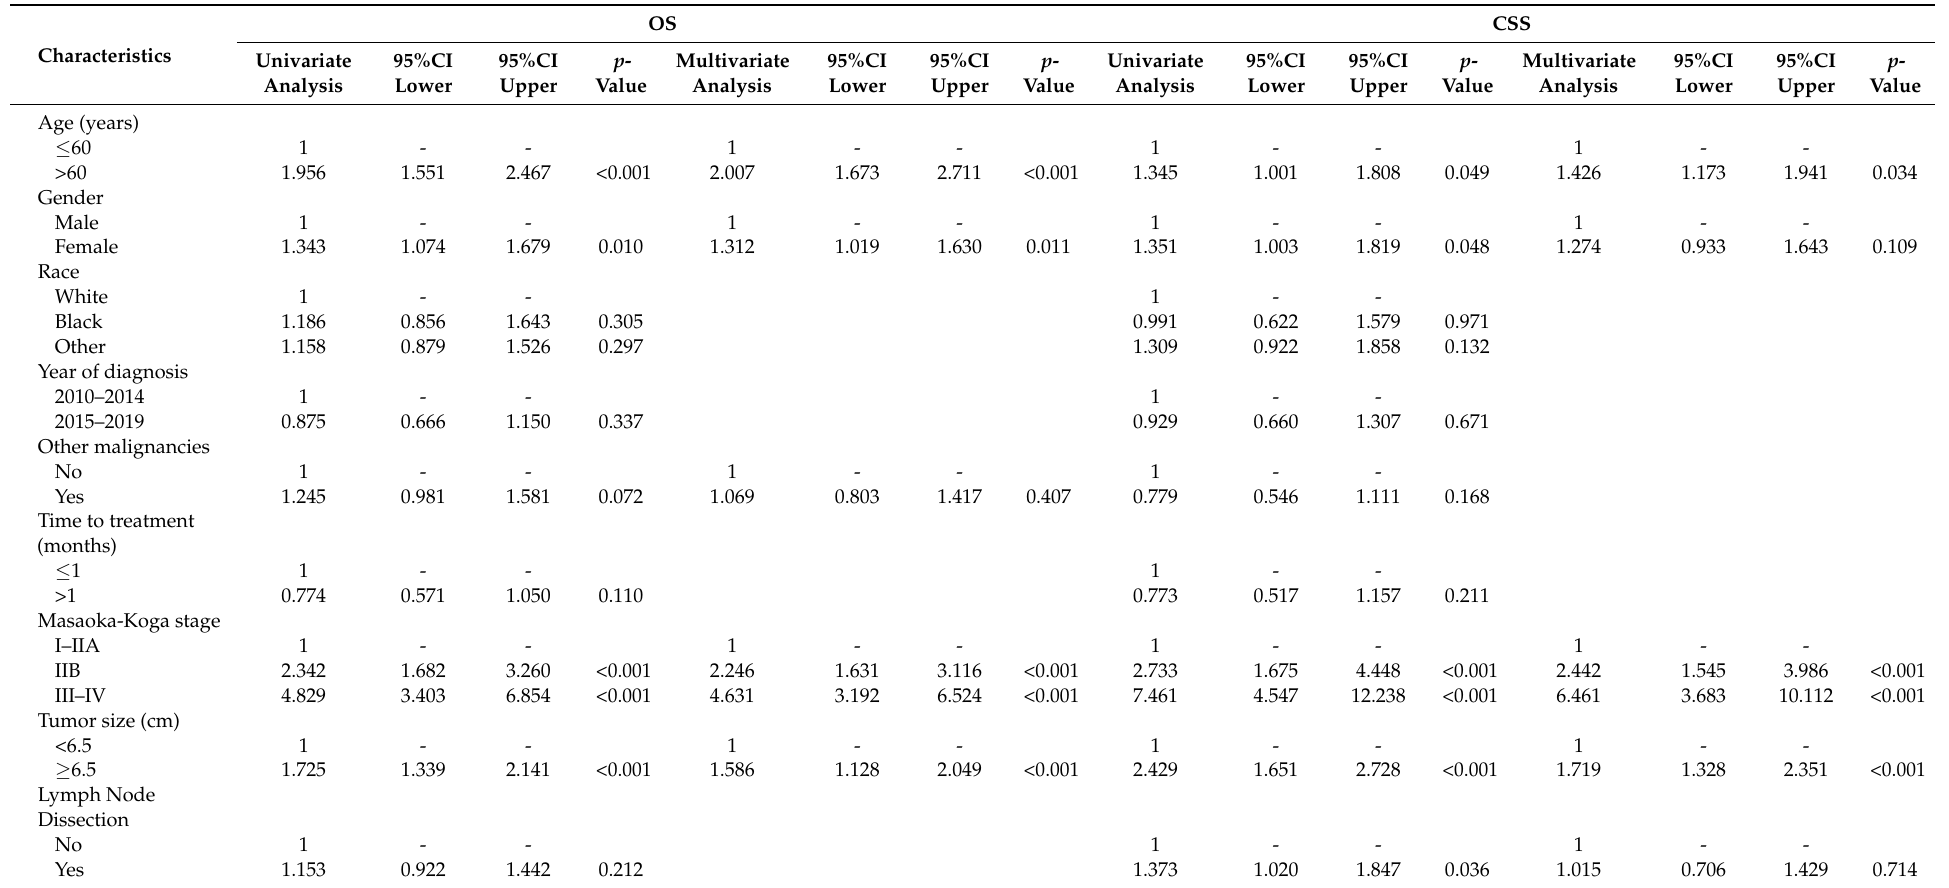
Table 4. Univariate and Multivariate Cox regression analysis of clinical characteristics for overall survival and cancer-specific survival rate in thymoma patients in the matched